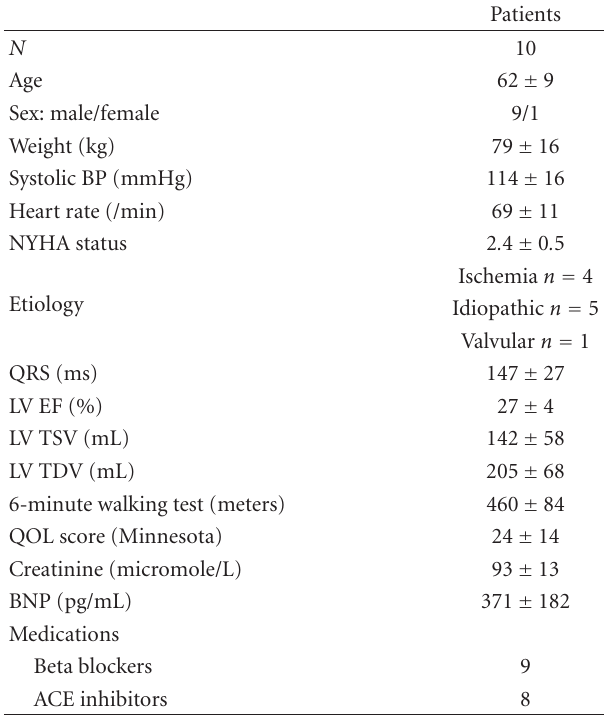
Table 1: Baseline characteristics. Values are given as means ± S.E.M. BNP, brain natriuretic peptid; BP, blood pressure; EF, ejection fraction; LV, left ventricle; QOL: quality of life; TDV,